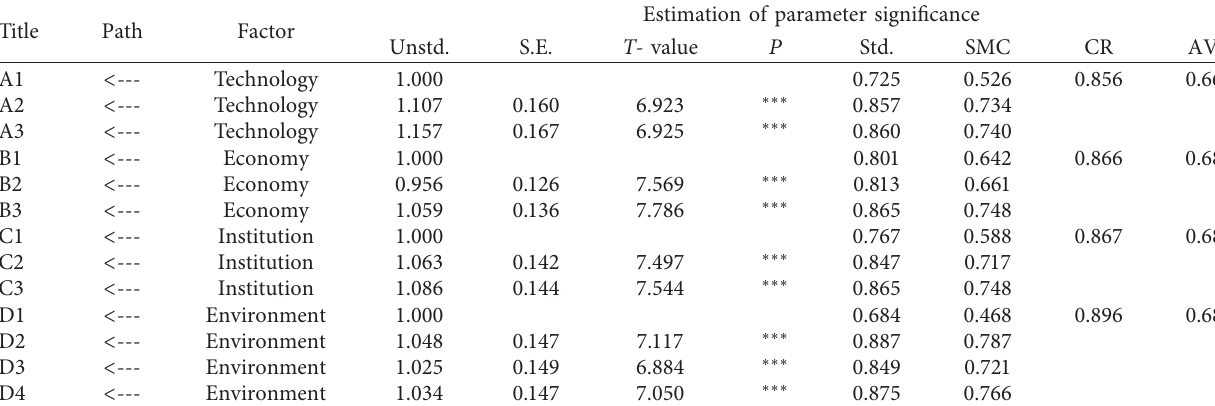
Table 9: Factor measurement model parameter estimation.